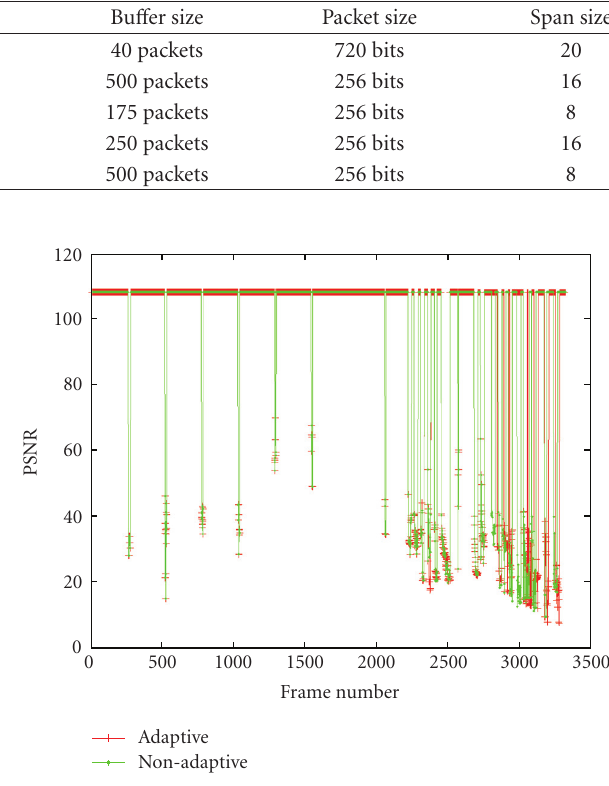
Figure 6: PSNR comparisons for “ all” sequence at 32kbps, random delay 0.026, bu ff er size 500, packet size 256, span 16, PL rate